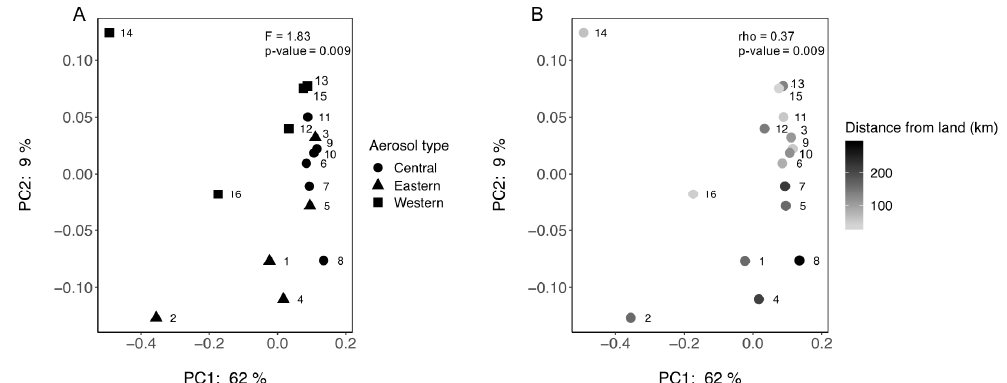
Figure 6. PCoA showing the differences in beta diversity using weighted UniFrac with ( A ) shapes representing regions of the MS samples were collected in, and ( B ) distance (km) between each sample site and closest landmass.